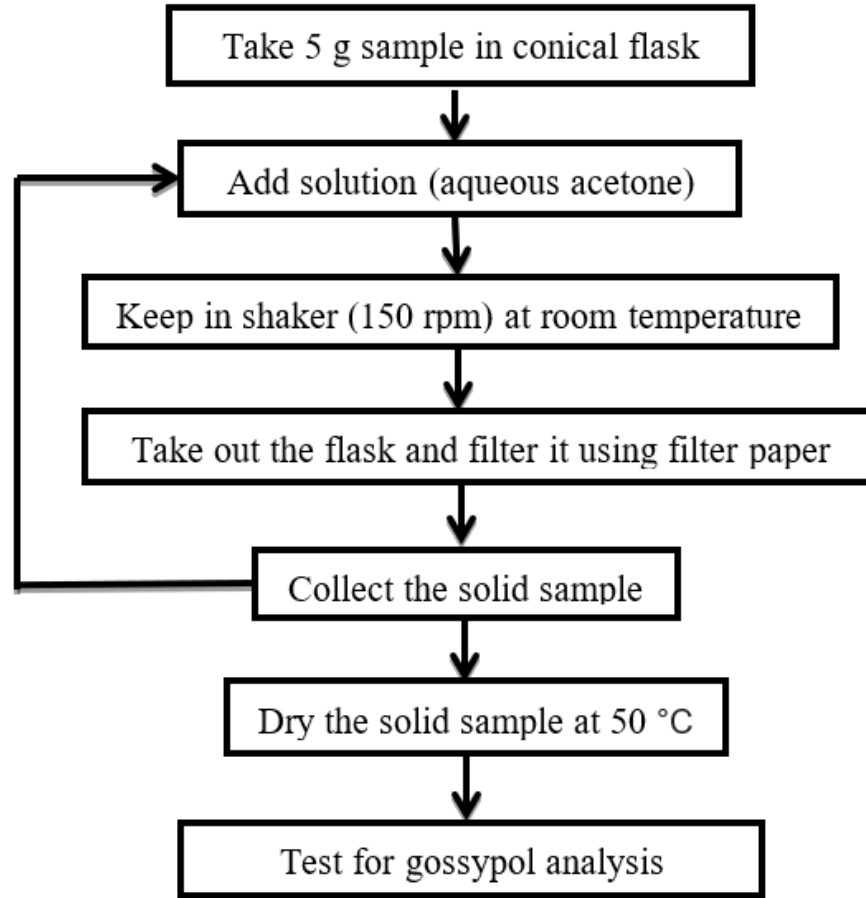
Figure 1. Schematic layout of experimental procedure for gossypol extraction.